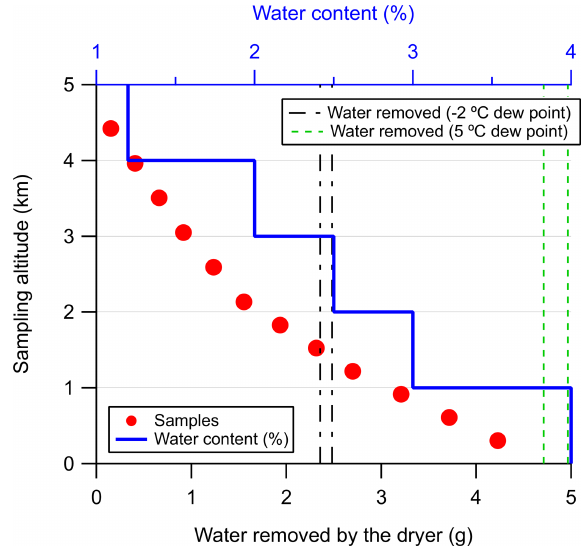
Figure 3. A simplified estimation of the total amount of water that the Nafion™ dryer has to remove during a typical flight over the Amazon. Twelve samples are collected gradually from a height of about 4.4km down to about 300m (a.m.s.l.). The water vapor con- tent in the air at a given altitude is shown with the solid blue line. This value has been assumed constant over every 1km altitude bin and was the maximum value observed in the sounding data, col- lected during the wet season over Rio Branco and Santarém, over the altitude bin. The black and green dashed lines indicate the lower and upper boundaries for the number of samples that can be col- lected with a dew point lower than − 2 ◦ C (at 275kPa) and 5 ◦ C (at 275kPa), respectively. These lower and upper boundaries were estimated from the experiment shown in Fig.